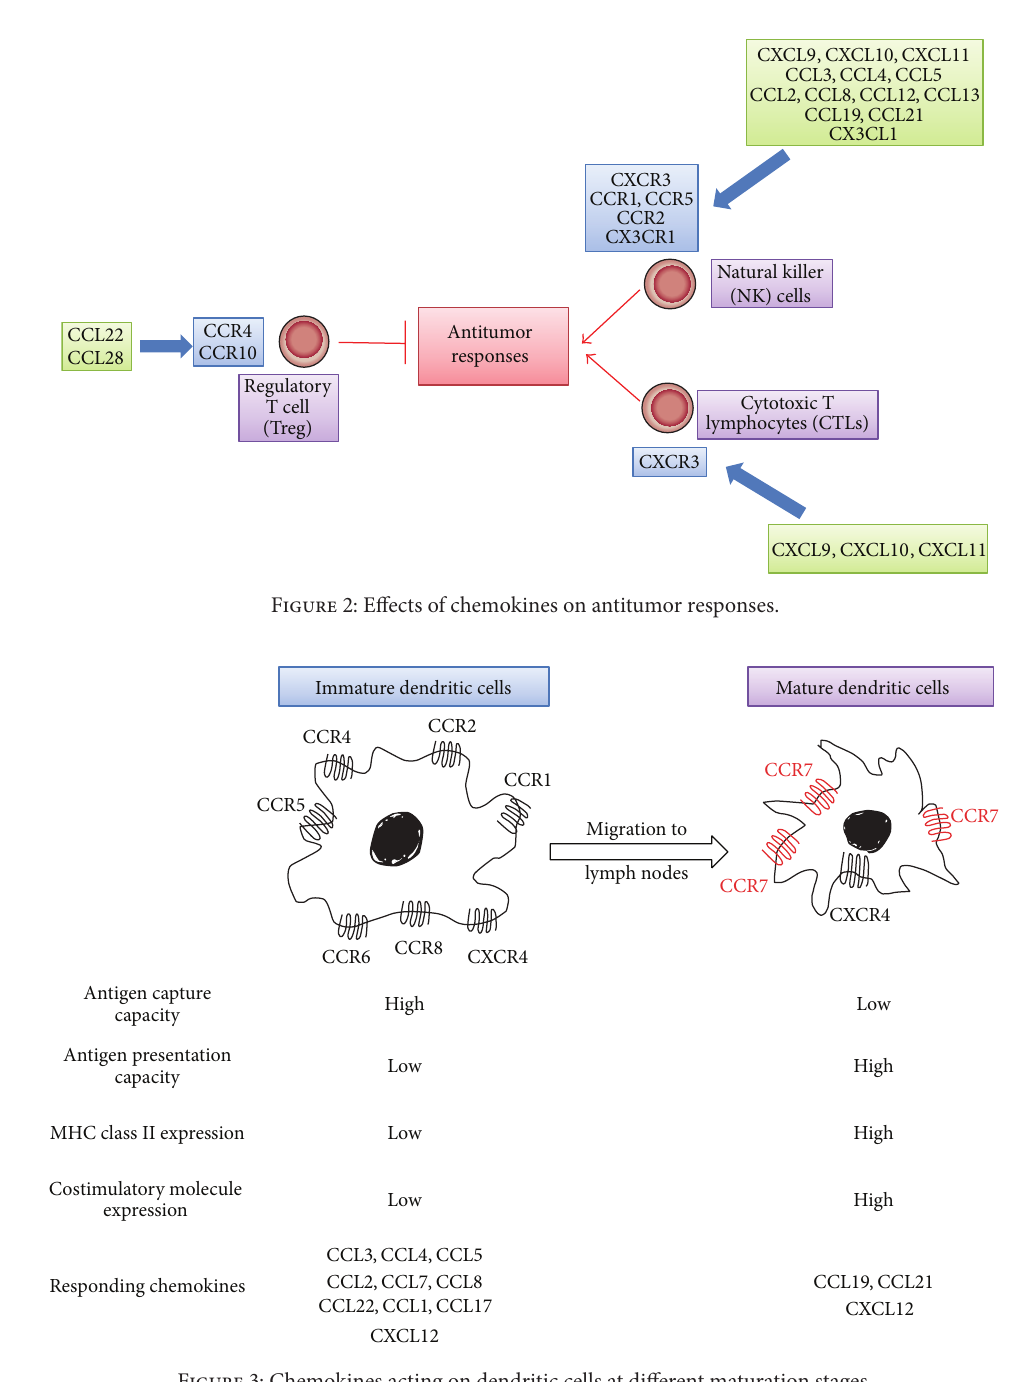
Figure 3: Chemokines acting on dendritic cells at different maturation